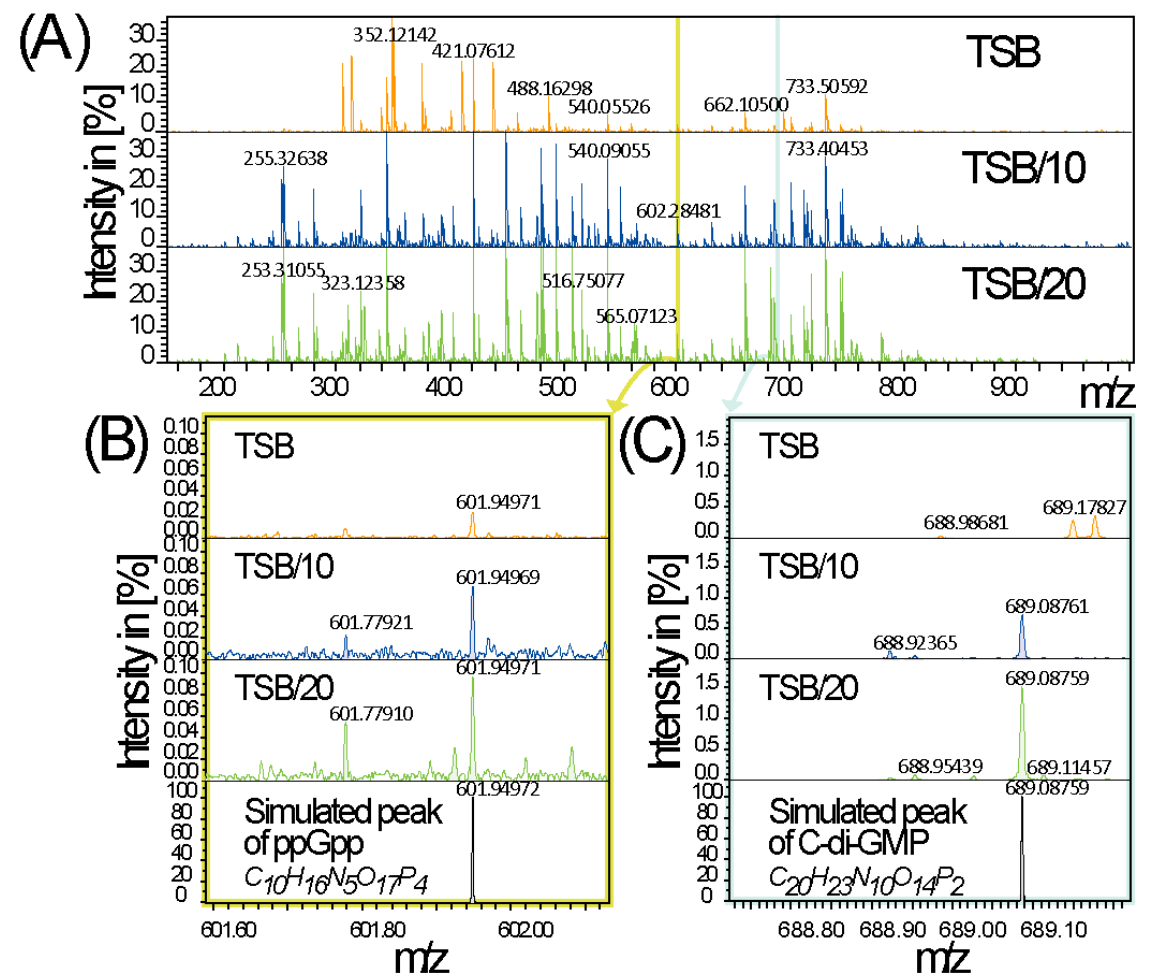
Figure 6. Signal molecules analysis. ( A ) Full ICR-FT/mass spectra of the wild type (WT) grown in TSB, tenfold dilutes TSB (TSB/10) and twenty-fold diluted TSB (TSB/20). ( B , C ) detection of (p)ppGpp and c-di-GMP compounds as annotated using metabolome database (MassTRIX: Suhre and Schmitt-Kopplin, 2008).